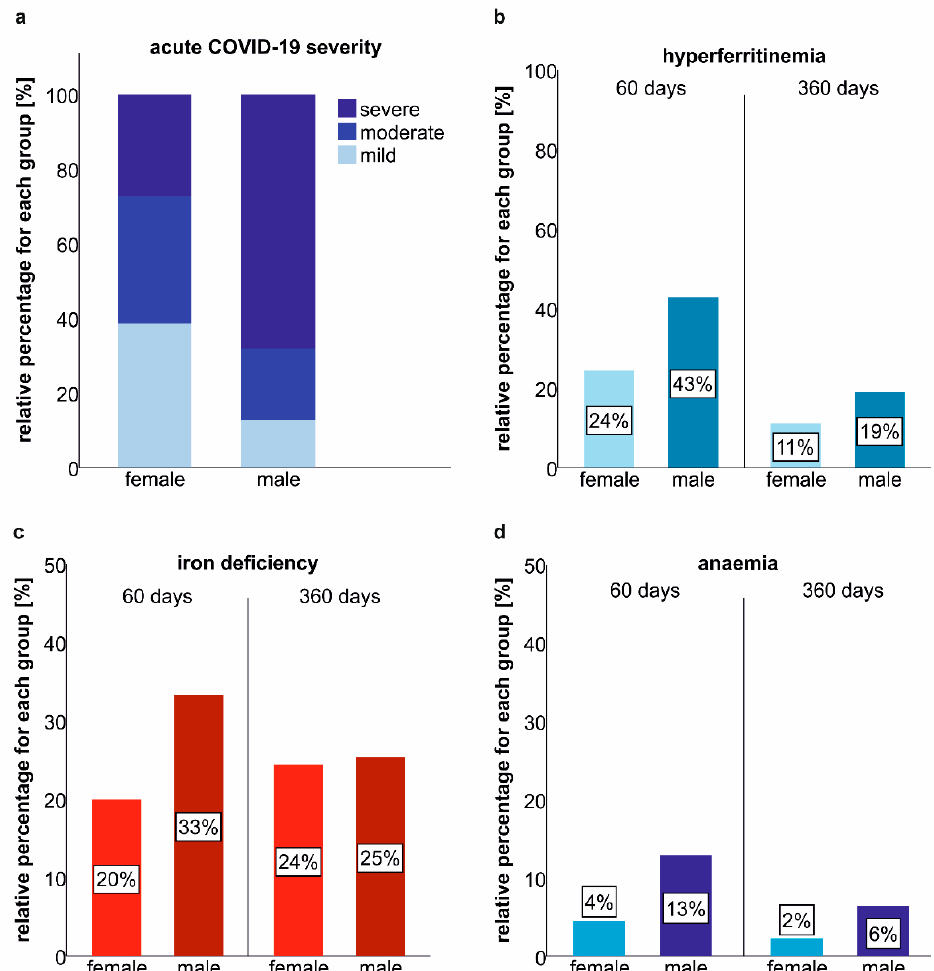
Figure 3. Gender-related differences in iron deficiency and anaemia prevalence after COVID-19. ( a ) Severity of acute COVID-19 according to gender. ( b ) Frequency of hyperferritinaemia according to gender 60 and 360 days after COVID-19 onset. ( c ) Iron deficiency in females and males 60 and 360 days after COVID-19 onset. ( d ) Anaemia in females and males 60 and 360 days after COVID-19 onset.